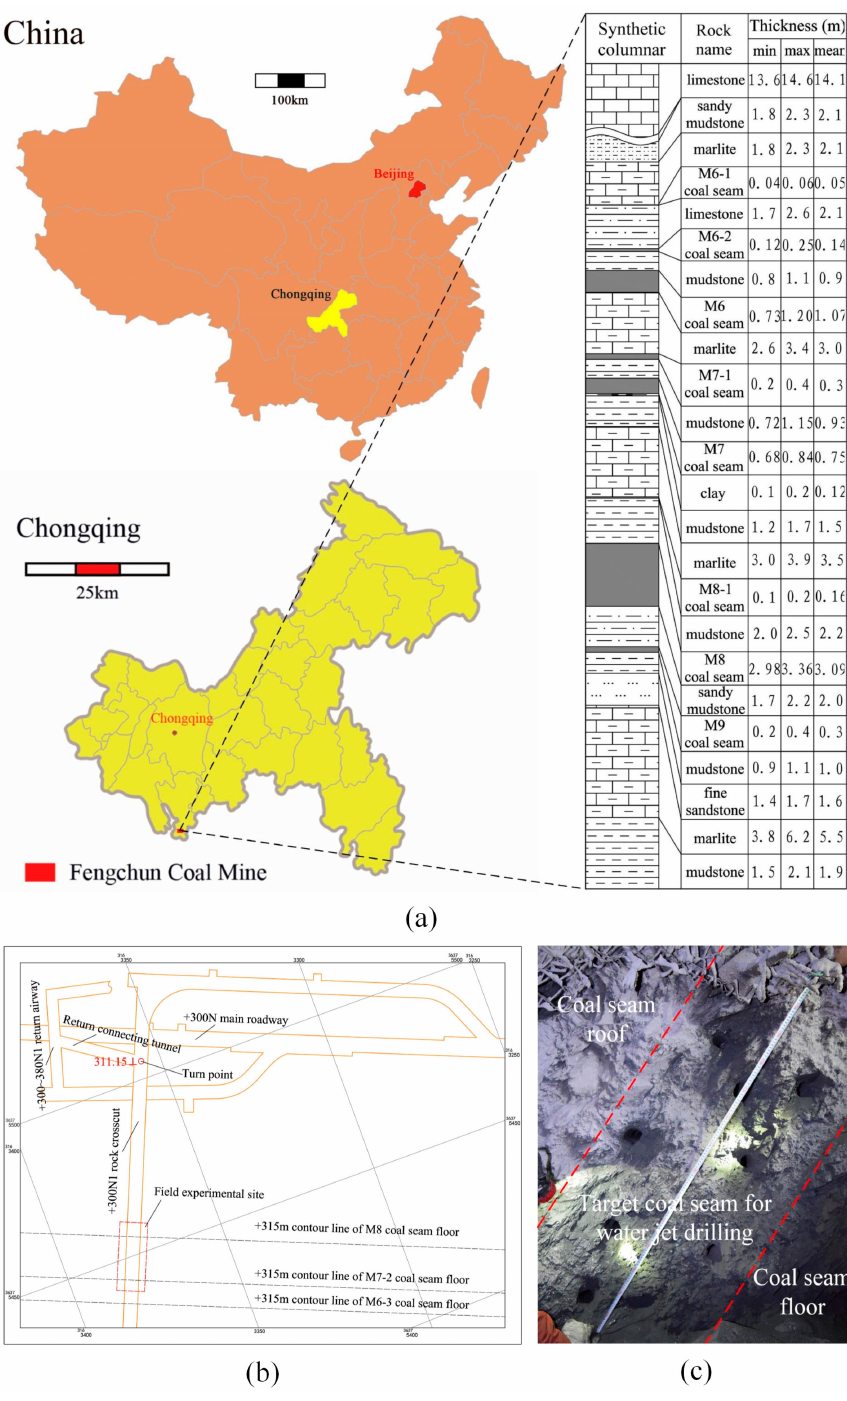
Figure 3. Field experimental site of WJD at the Fengchun coal mine: ( a ) Field experimental site of WJD and the geological histogram at the +300N1 rock crosscut; ( b ) Sketch map of field experimental site; ( c ) Target coal seams for